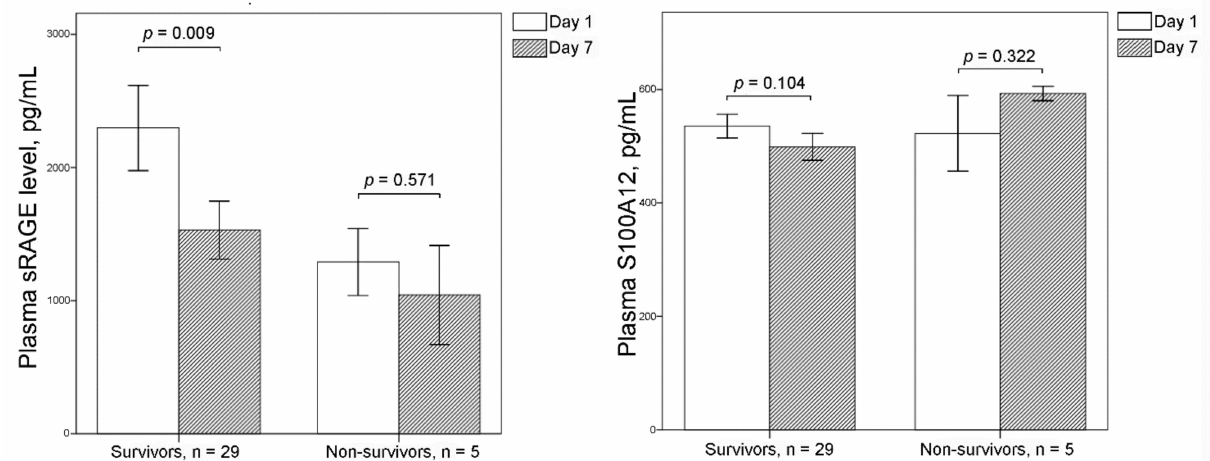
Figure 1. Plasma levels of advanced glycation endproducts (AGE), soluble RAGE (sRAGE), high- mobility group box 1 (HMGB1), and S100A12 on Days 1 and 7 are shown using bar charts with one standard error. In survivors, plasma AGE levels were significantly increased and plasma sRAGE levels were significantly decreased after 6 d. There were no changes in plasma levels of AGE and sRAGE in non-survivors. Plasma levels of HMGB1 and S100A12 did not change in survivors and non-survivors after 6